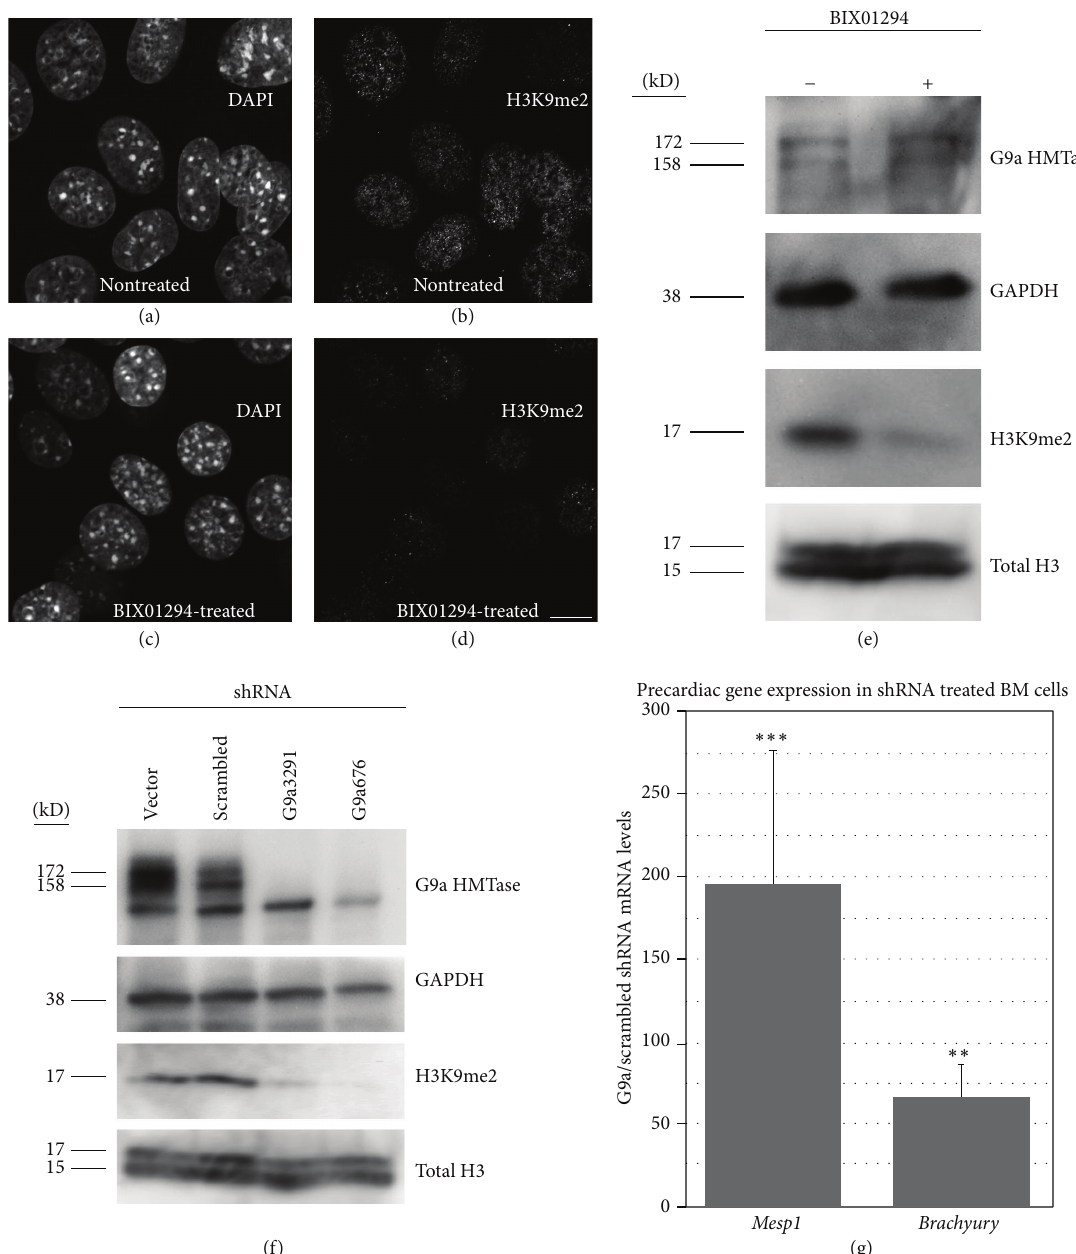
Figure1:EffectofG9aHMTaseinhibitiononbonemarrowcells.(a–d)FluorescentstainingofnontreatedandBIX01294-treatedbonemarrow stem cells with DAPI for labeling all nuclei and antibody specific for dimethylated form of histone H3 at lysine 9 (H3K9). (e) Immunoblot of protein isolated from nontreated and BIX01294-treated bone marrow stem cells. Data from panels (a)–(e) demonstrate that methylation of H3K9 is reduced upon exposure to BIX01294. Blotting for GAPDH and total histone H3 verified equal amounts of protein were added